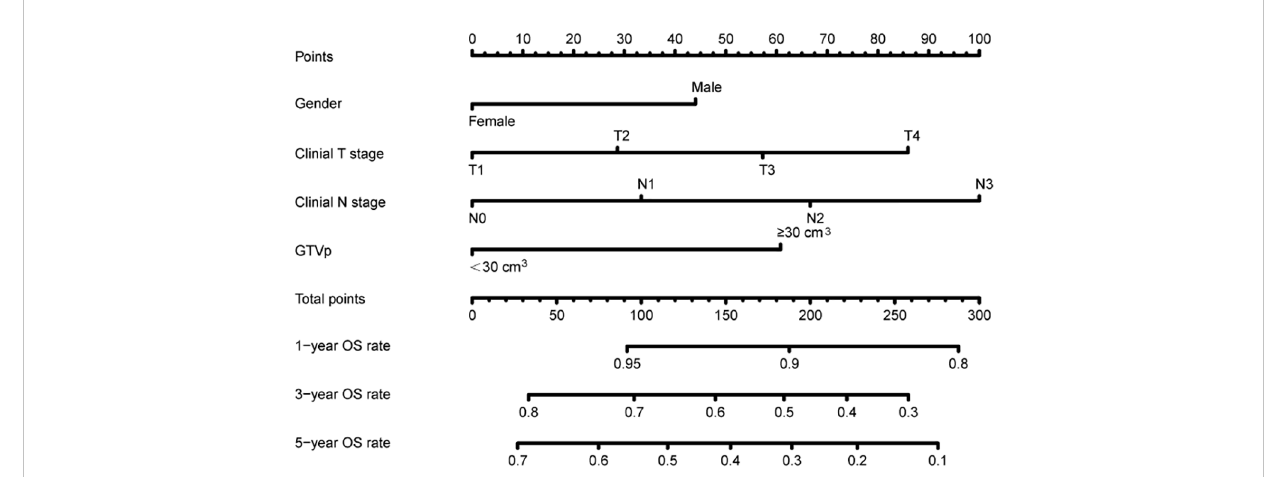
FIGURE 1 Nomogram predicting overall survival based on prognostic factors developed from the training cohort.